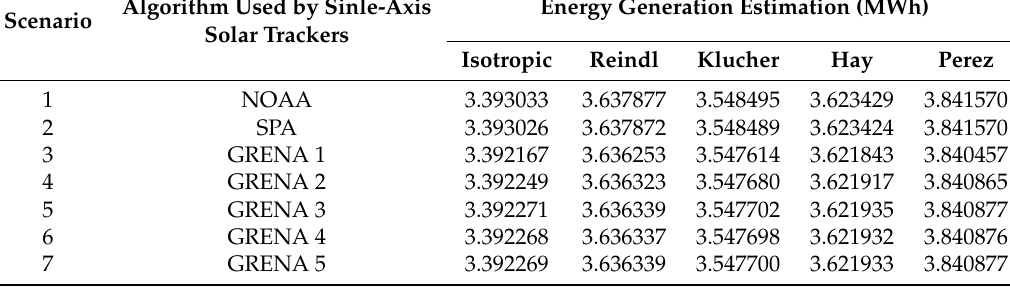
Table 5. Result of energy generation estimation using different algorithms for Sun tracking in Kiruna,